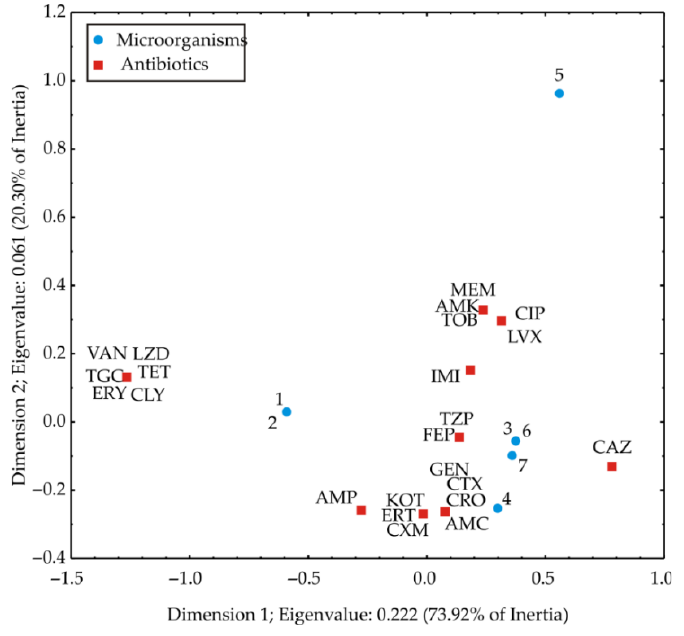
Figure 7. Correspondence plot diagram for antibiotic susceptibility patterns for respiratory-associ- ated bacteria. associated